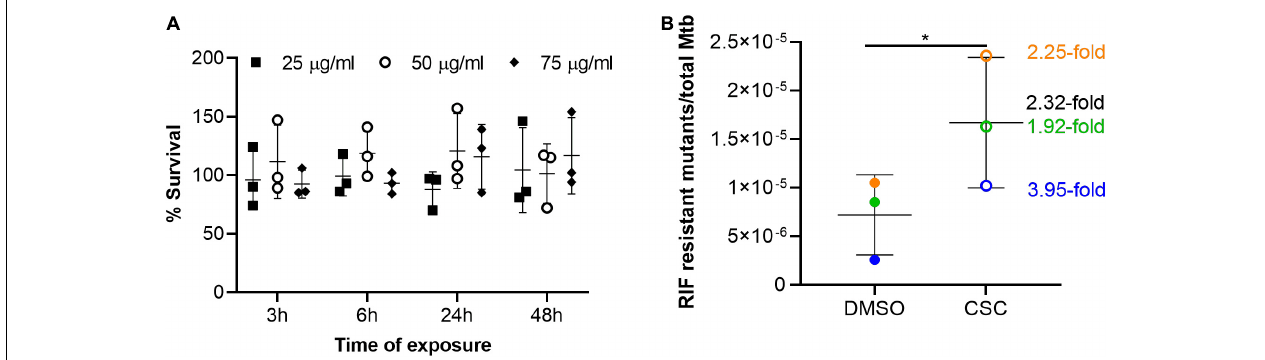
FIGURE 1 | Survival and mutation frequency in Mtb exposed to CSC. (A) Survival of Mtb upon exposure to 25, 50, and 75 µ g/ml CSC for 3, 6, 24, and 48 h relative to survival upon exposure to the diluent, DMSO, which was set as 100%. Multiple t -tests were done ( n = 3), without assuming standard deviation and without correction for multiple comparisons. No significant differences were observed. (B) Frequency of RIF-resistant mutants, determined by CFU on 7H11 agar RIF (2 µ g/ml), compared to bacterial count in the culture, determined by plating dilution series on 7H11 agar. Three independent experiments ( n = 3) were done and are indicated in different colors. The fold difference in mutation frequency between CSC and DMSO is indicated in the corresponding color with black indicating the mean fold change. The error bars indicate the mean and standard deviation. A paired, two-tailed t -test indicated significant increase in mutation frequency upon exposure to CSC ( p = 0.034). * p < 0.05.